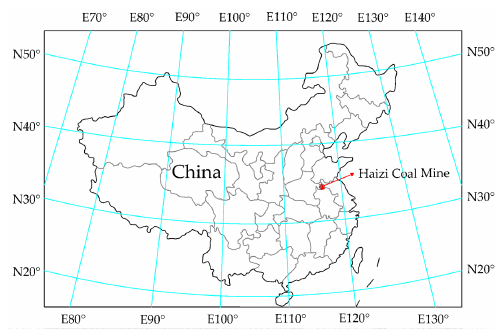
Figure 2. Location of Haizi coal mine.